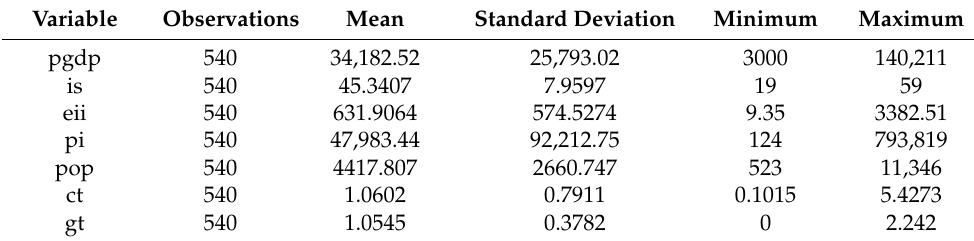
Table 3. Descriptive statistics.